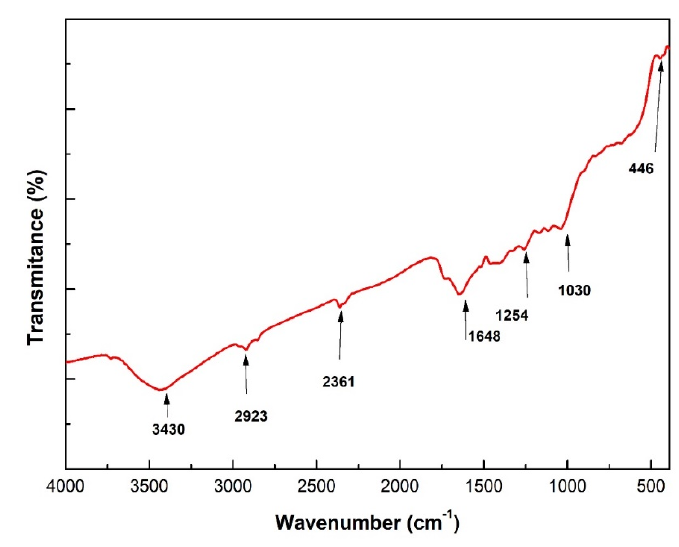
Figure 2. Fourier transform infrared (FT-IR) spectrum of the CM sedge fiber. Table 1. Izod impact energies for the neat epoxy resin and Cyperus malaccensis (CM) fiber-reinforced composites.